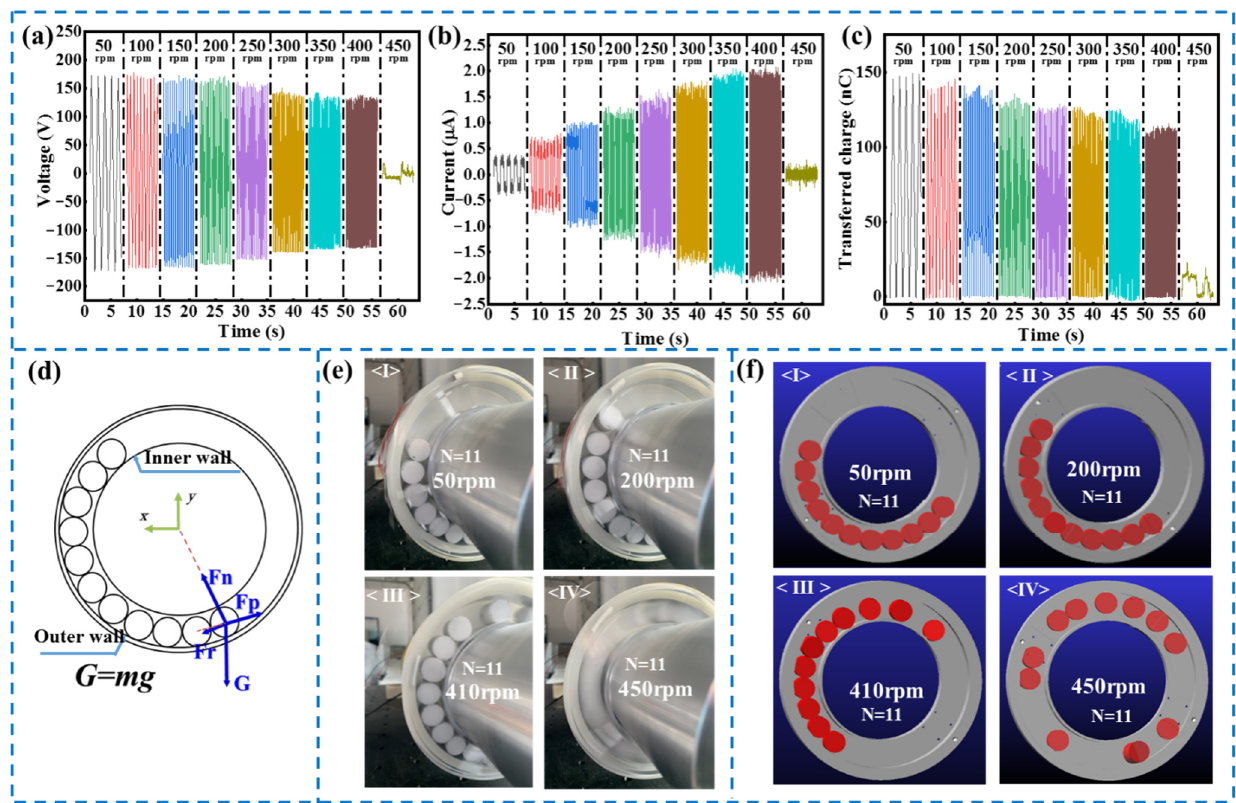
Figure 4. Rotational speed characteristics of the R-TENG: ( a ) output voltage, ( b ) current and ( c ) transferred charge of R-TENG with 11 PTFE cylinders at different rotational speeds; ( d ) schematic illustration of the dynamic analysis of the PTFE cylinders rolling in the container; ( e ) photograph of the rotating R-TENG at different rotational speeds; ( f ) kinetic simulation of PTFE cylinders at different rotational speeds via ADAMS.